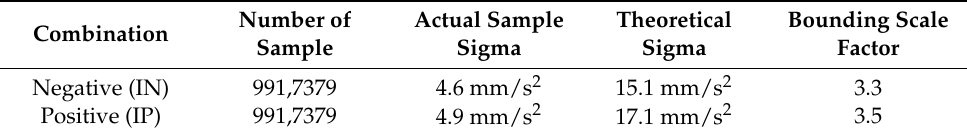
Figure 4. Folded cumulative distribution function of nominal monitoring values (note that the scale of its vertical axis is logarithmic): ( a ) ionospheric negative acceleration; ( b ) ionospheric positive acceleration. Table 1. Statistics of actual error distribution of the monitoring